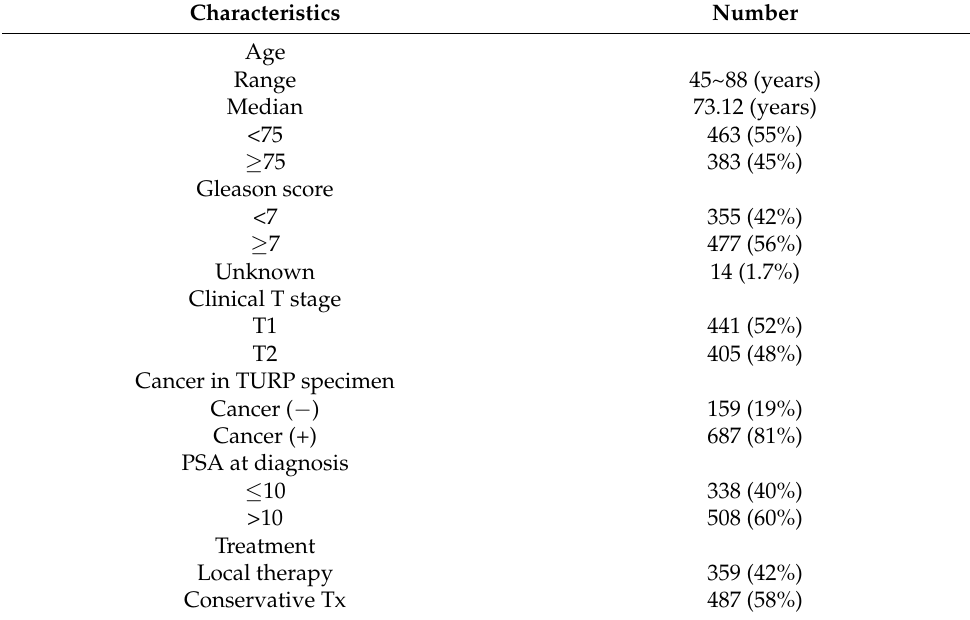
Table 3. Characteristics of patients with stage T1-2N0M0 who underwent TURP at diagnosis.